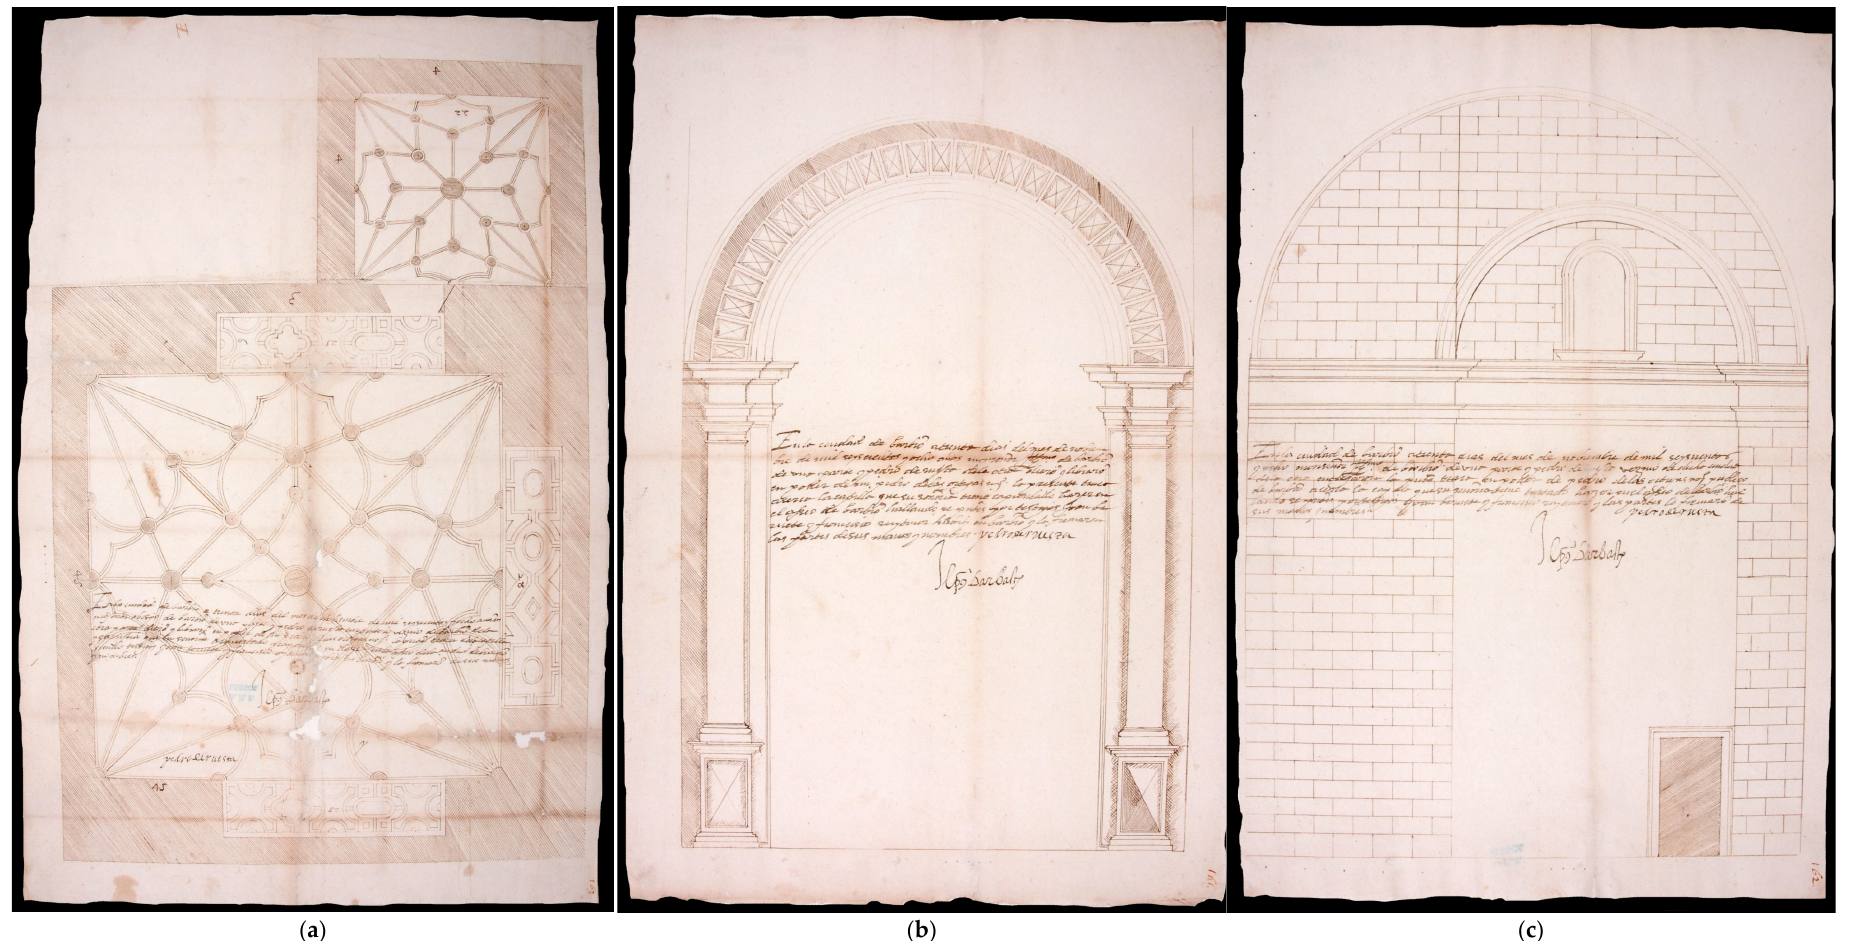
Figure 9. ( a – c ) Project for the chapel of Juan Moriz de Salazar, bishop of Barbastro (Huesca), in Barbastro cathedral [A.H.P.HU., ES/AHPHU-011837/5, 6, y 7]. © Archivo Histórico Provincial de Huesca.